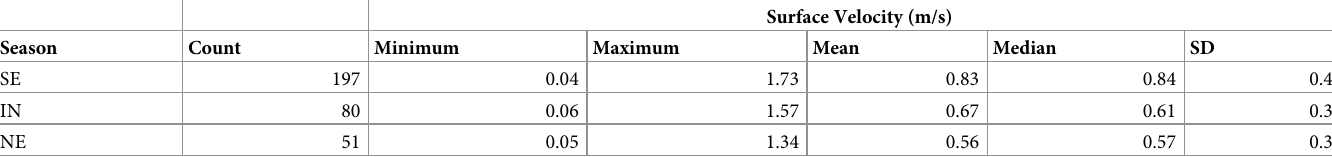
Surface Velocity (m/s)